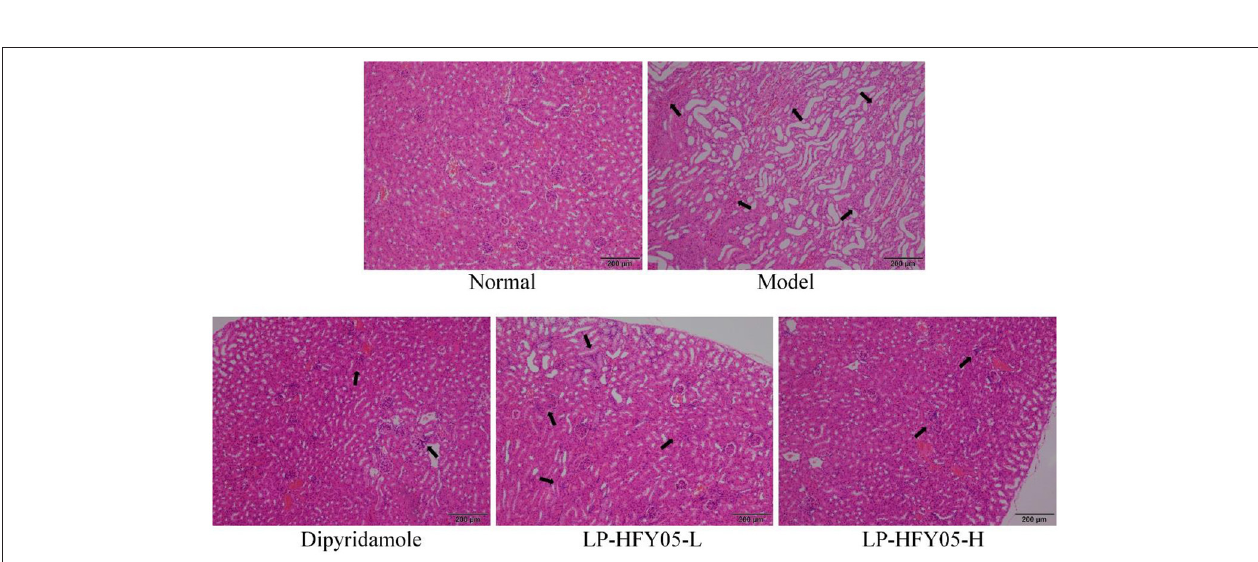
FIGURE 4 | Image of hematoxylin and eosin-stained tail vein vessels in mice. The arrow points to damaged cells.